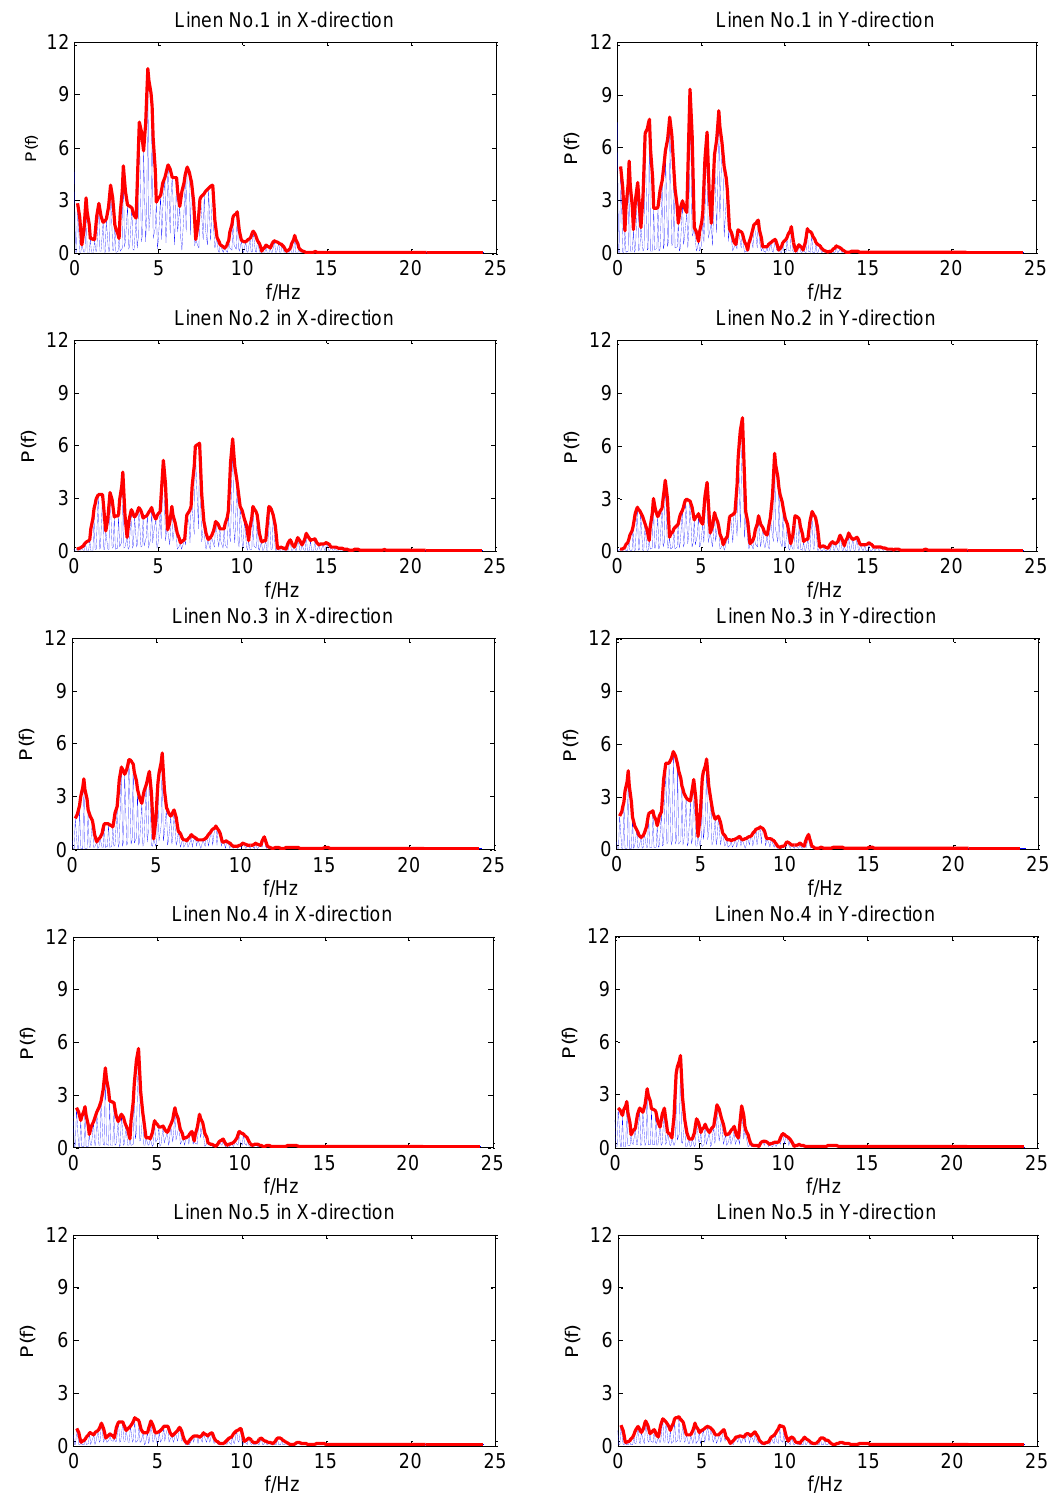
Figure 8. The power spectrum density of five types of